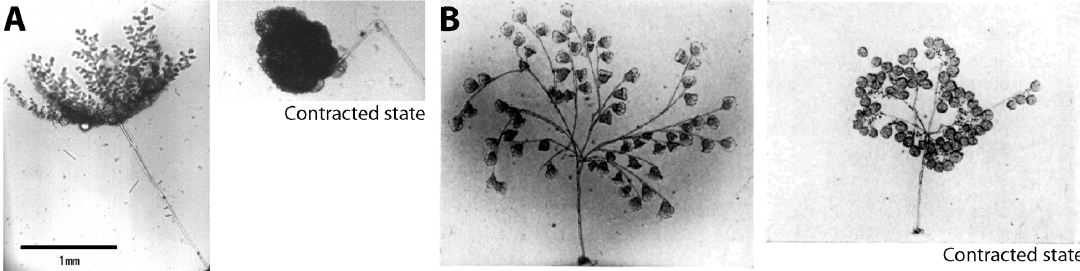
Figure 2. Other protozoa with Ca 2+ -driven stalk contraction. ( A ) Zoothamnium (reproduced from [58]); ( B ) Carchesium (reproduced from [59]).